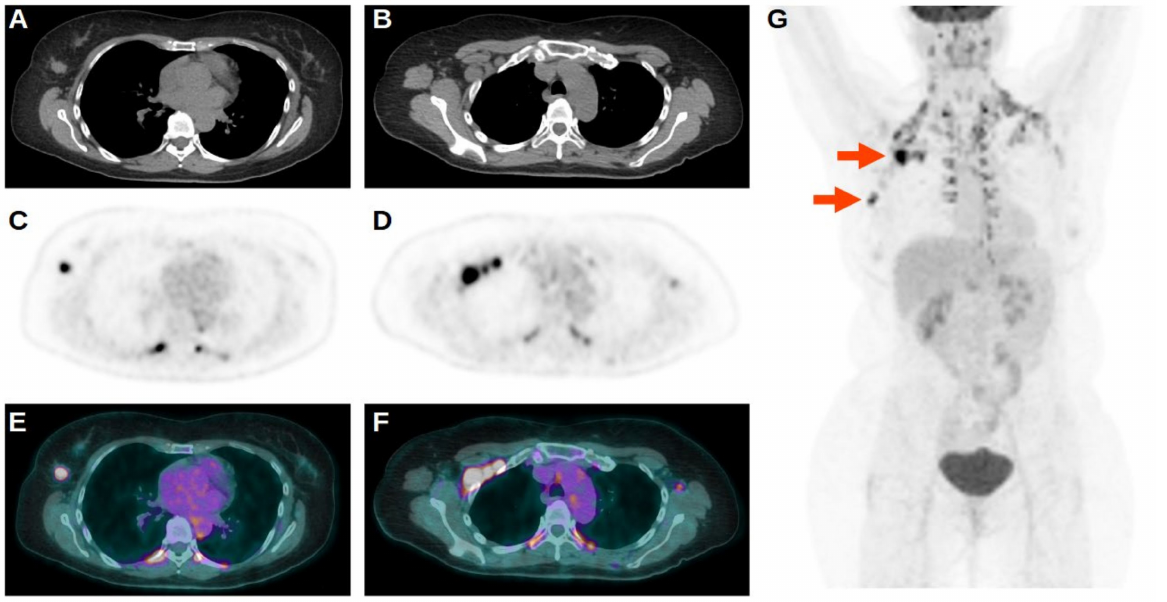
Figure 1. Axial CT ( A , B ), axial PET ( C , D ), axial fused PET/CT, ( E , F ) and maximum intensity projection (MIP) ( G ) of a [ 18 F]FDG PET/CT scan performed in a patient positive for BRCA1 mutation, demonstrating intense uptake of tracer on primary right BC and concomitant multiple focal uptakes on metastatic axillary and retropectoral nodes (red arrows on MIP). Brown adipose tissue activation was also